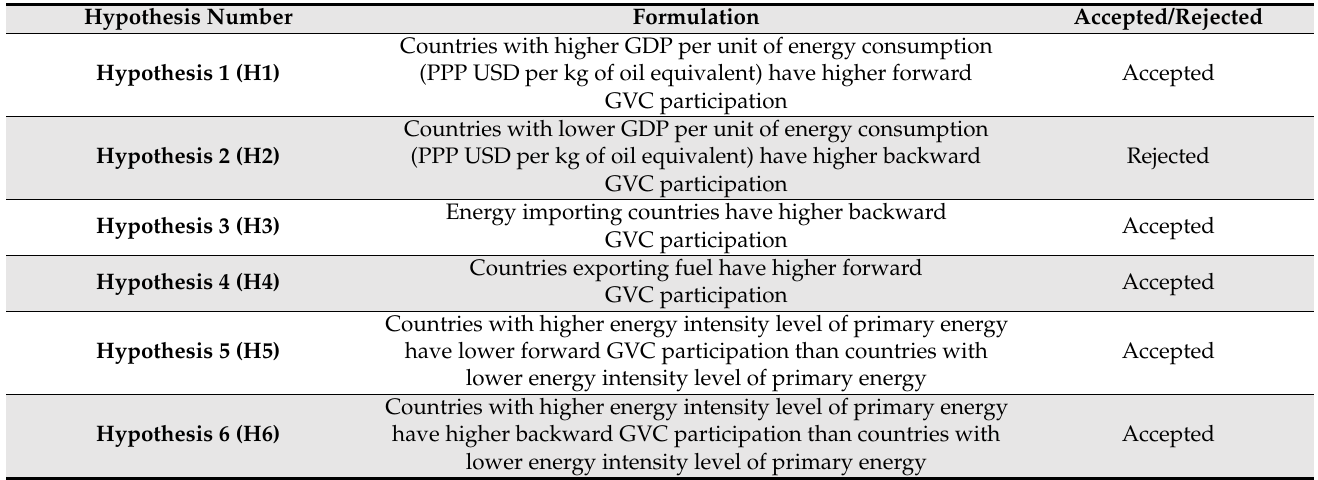
Table 1. Hypotheses about the relationship between countries’ energy indicators and the GVC participation